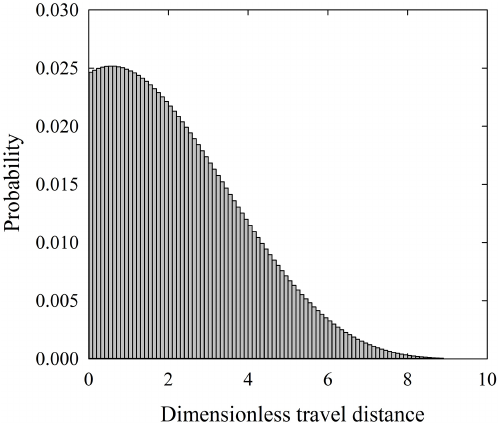
Figure 7. Probability mass function f k ( k ; ˆ x ) of discrete travel dis- tances k associated with initial net heating over small k followed by net cooling with increasing k , leading to a finite mode. In this example the Kirkby number starts at Ki = 0 . 90 at k d ˆ r = ˆ x = 0 and decreases to Ki = 0 . 57 at k d ˆ r = ˆ x =